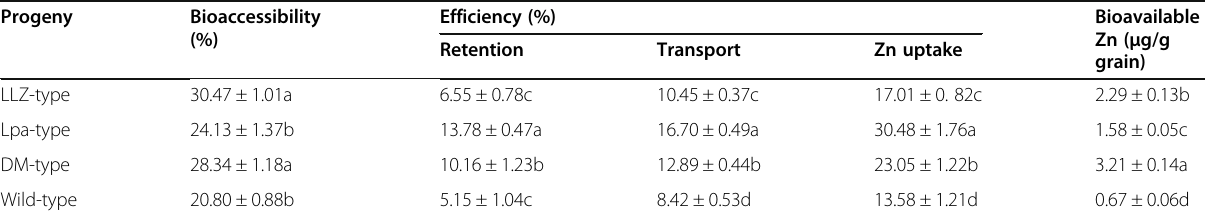
Data represent the mean±SEM of 4 samples replicate. Different letters behind the values indicate statistically significant differences by LSD ( P